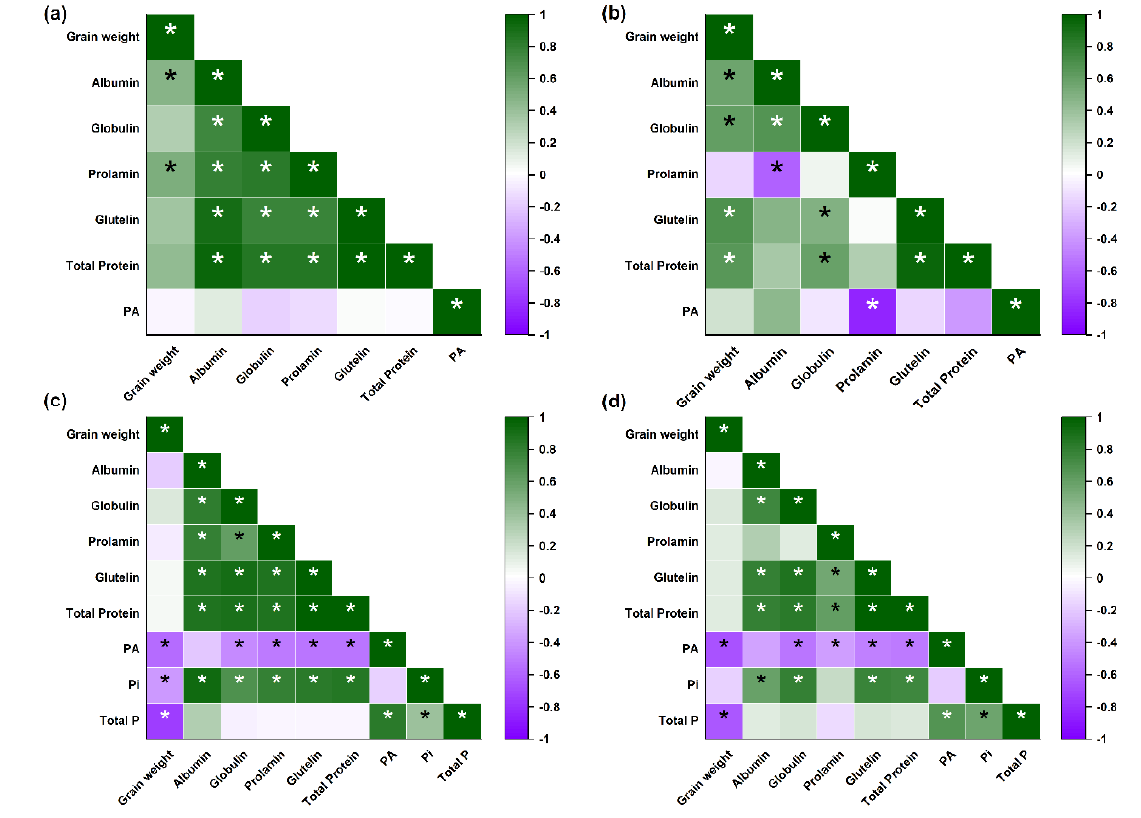
Figure 5. Pearson correlation among grain phytic acid (PA) and protein fractions for the following: ( a ) XS110 for hydroponic culture; ( b ) HIPJ for hydroponic culture; ( c ) XS110 for detached panicle culture; ( d ) HIPJ for detached panicle culture. The symbol * represents significance at the level of p <